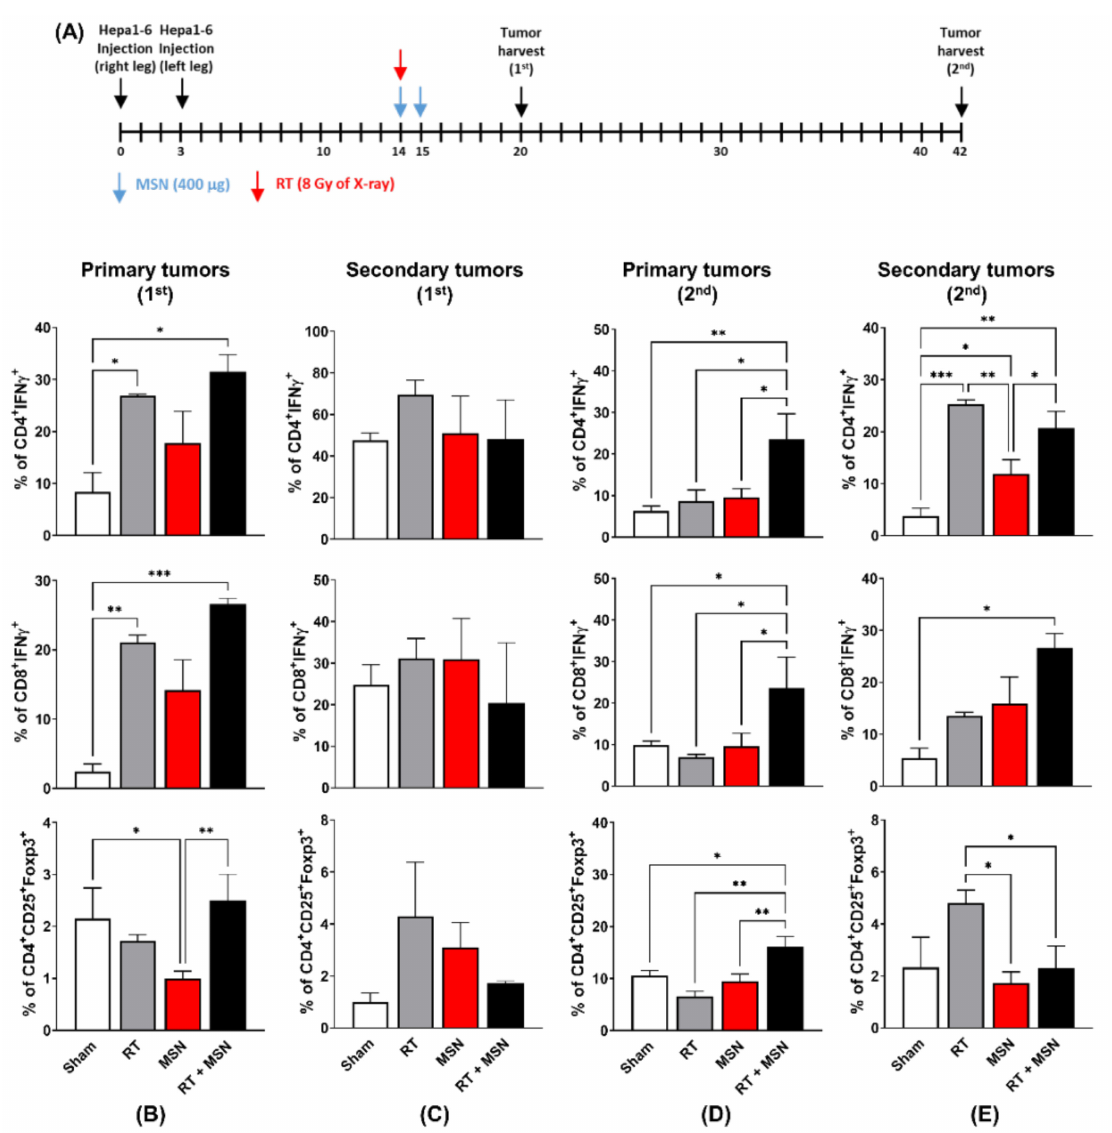
Figure 3. Direct injection of MSNs into irradiated primary tumors increases the number of cytotoxic T cells infiltrating the distal tumors. ( A ) Illustration of the treatment schedule and timing of tumor harvesting. ( B , C ) Profiling of activated T cells and Treg cells from primary ( B ) and secondary tumor tissues ( C ) harvested 20 days after tumor inoculation. ( D , E ) Profiling of activated T cells and Treg cells from primary ( D ) and secondary tumor tissues ( E ) harvested 42 days after tumor inoculation. * p < 0.05; ** p < 0.01; *** p <